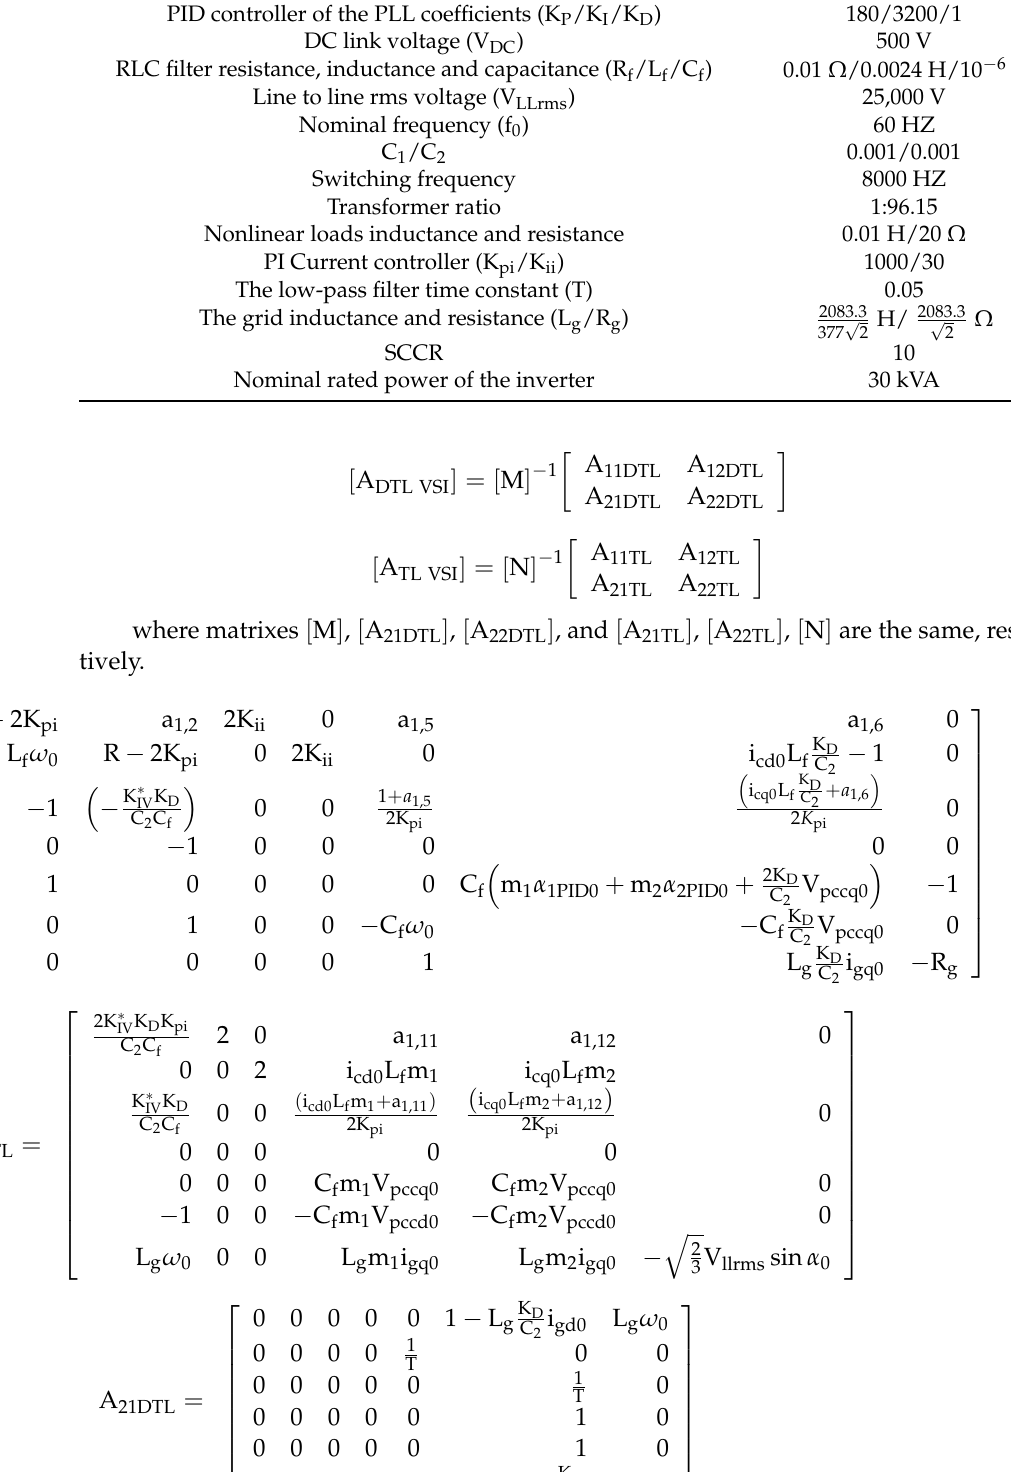
Table A1. System parameters. Parameter Value PID controller of the PLL coefficients (K P /K I /K D